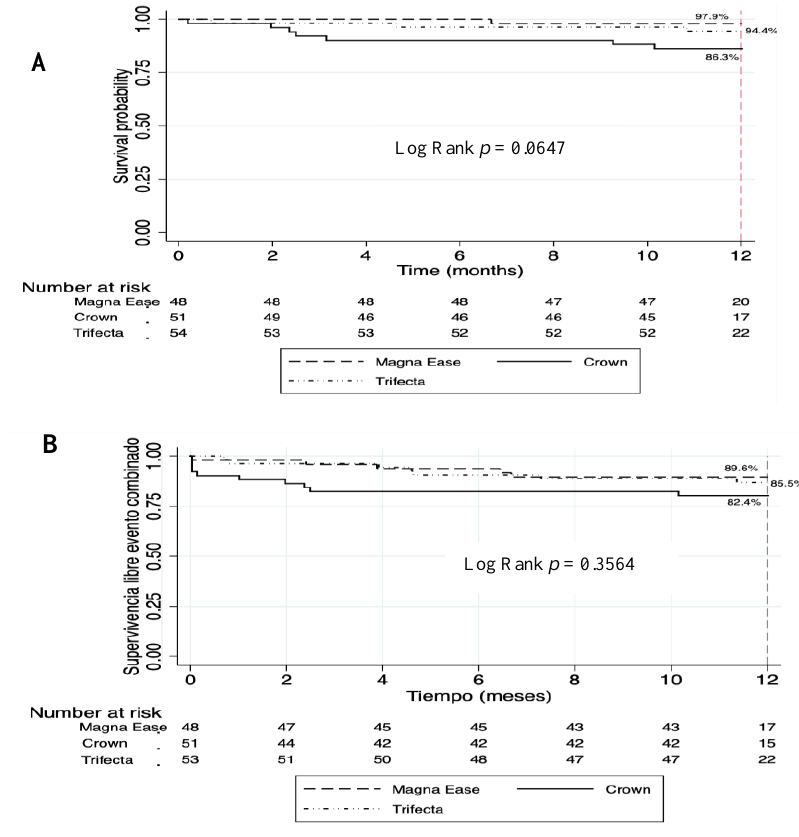
Figure 4. Kaplan–Meier survival graph ( A ) and Kaplan–Meier event-free survival graph by prosthesis Figure 4. Kaplan – Meier survival graph ( A ) and Kaplan – Meier event-free survival graph by pros- type ( B thesis type ( B ).